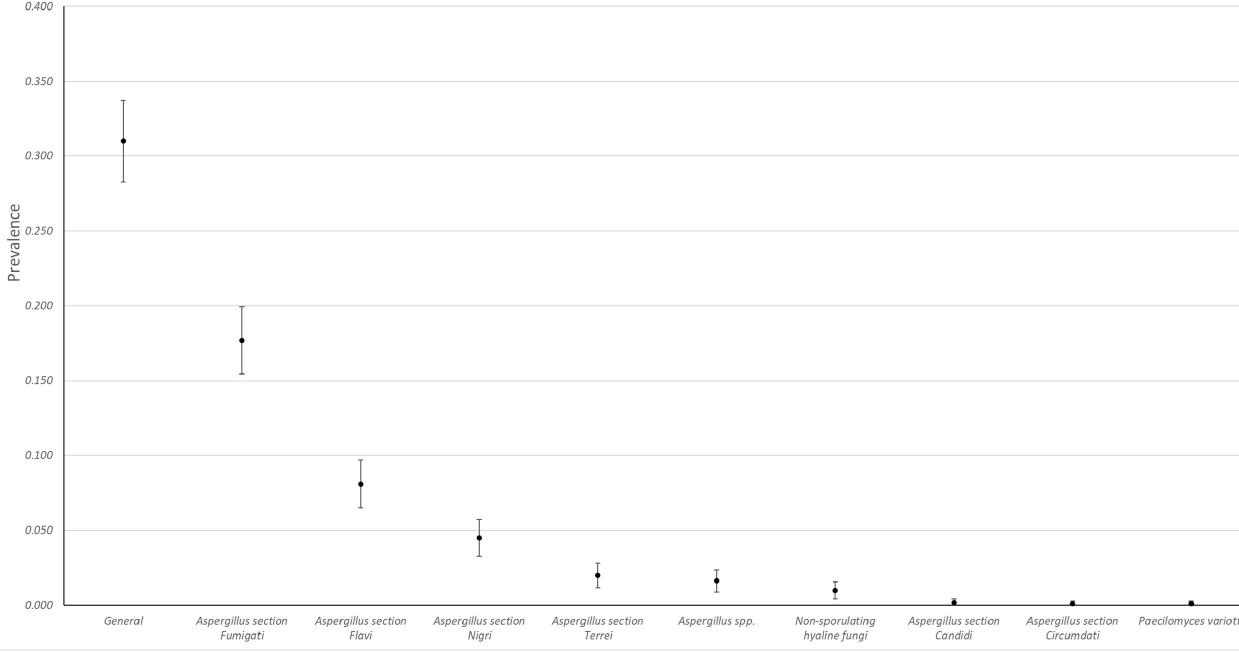
Figure 1. Observed prevalences (95% CI) of fungi isolated in chicken lungs ( Gallus gallus ) ranging from 2008 to 2021 in the Mycology Laboratory, School of Veterinary Medicine, Universidad Nacional, Heredia, Costa Rica.